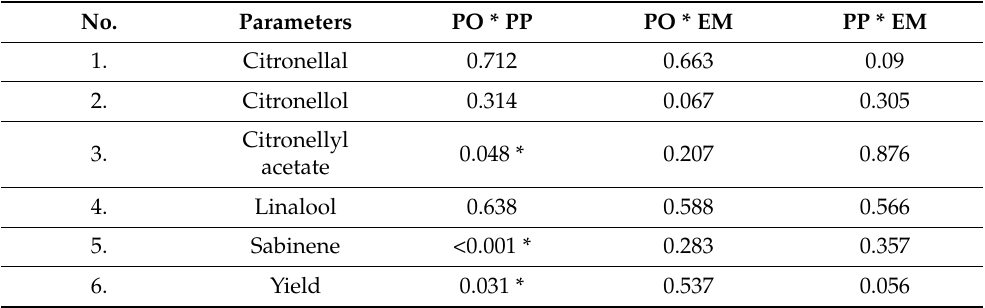
Table 8. p -value of several interaction among factors: plant origin, plant part, and extraction method on oil yield and main components of kaffir lime essential